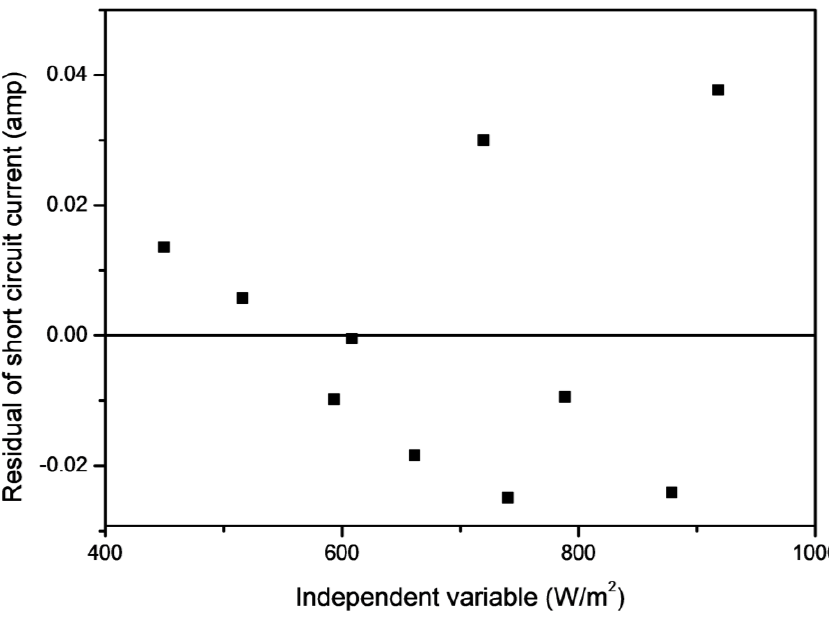
Figure 11. Residual plot for the developed mathematical relation. Table 7. Residuals of the model.